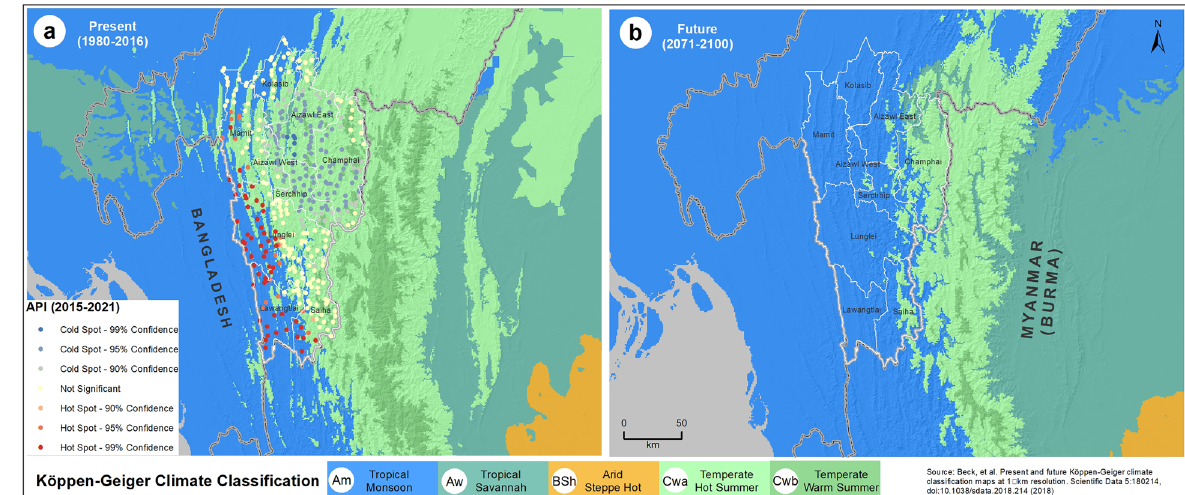
Figure 9. Climate types of Mizoram and adjoining regions using the Köppen-Geiger climate classification; ( a ) the present (1980–2016) and ( b ) future scenario (2071–2100) corresponding to RCP8.5 climate scenario. The map layout was created using licensed version of ArcGIS